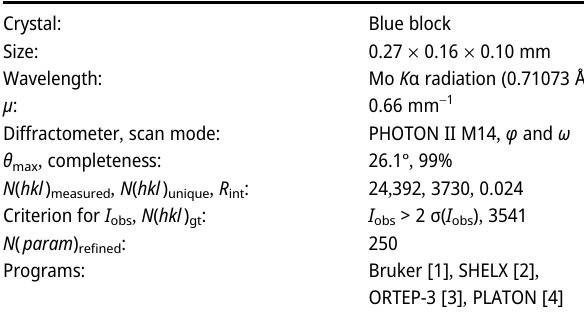
Table  : Data collection and